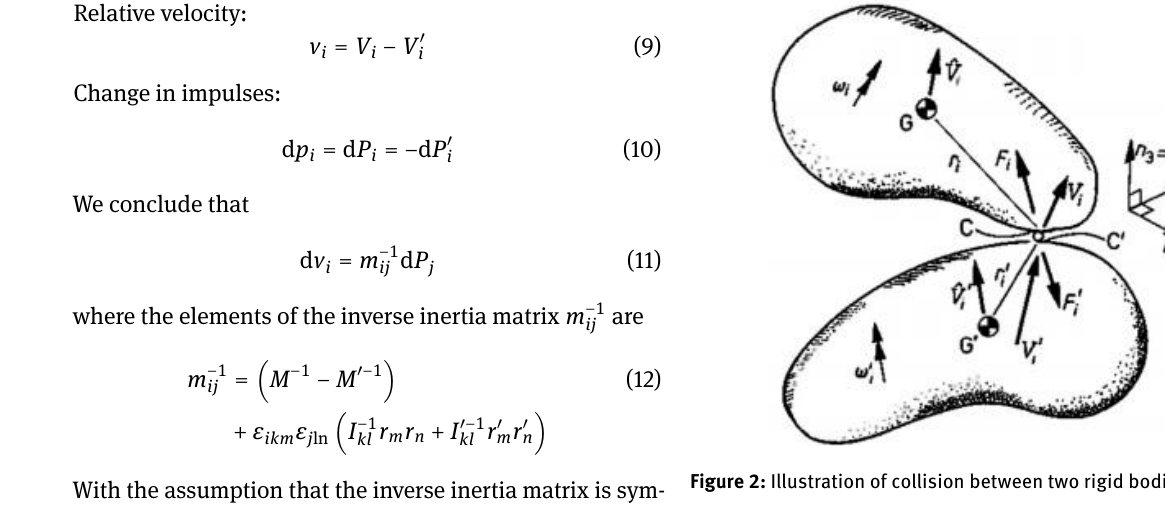
during impact, is closely related to the ship velocity and ma-